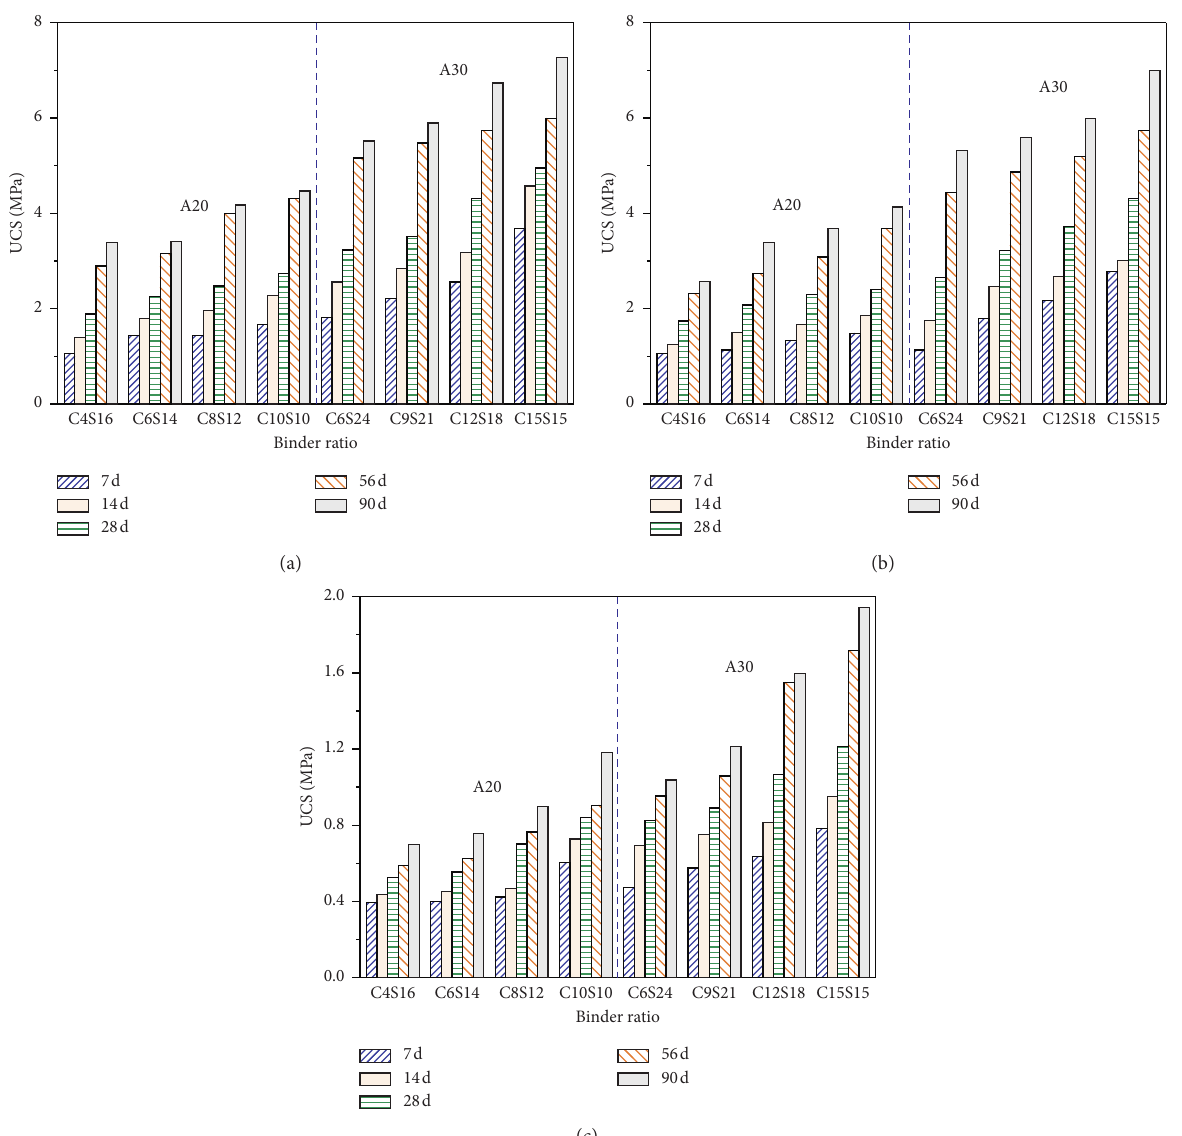
Figure 3: Evolutions of the UCS with binder ratio of the stabilized Cr-contaminated soils: (a) Cr0.1, (b) Cr0.5, and (c) Cr1.0.